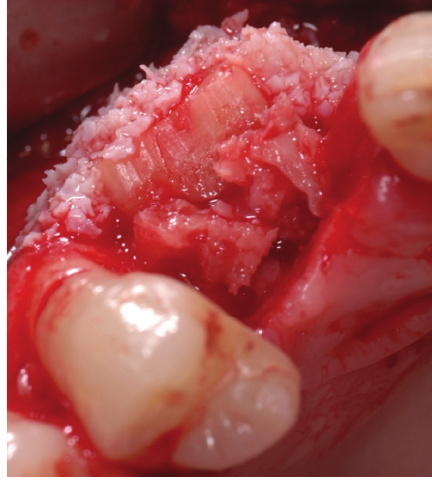
Figure 8: Particulated anorganic bovine bone placed on top of the bone block to reduce the physiological shrinkage of the graft due to bone